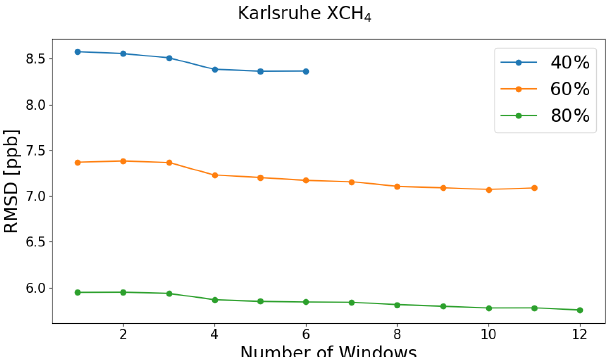
Figure A9. Root-mean-square deviation between CAMS-COCCON and COCCON with respect to number of windows for XCH 4 according to 40%, 60% and 80% COCCON data points at Karlsruhe.